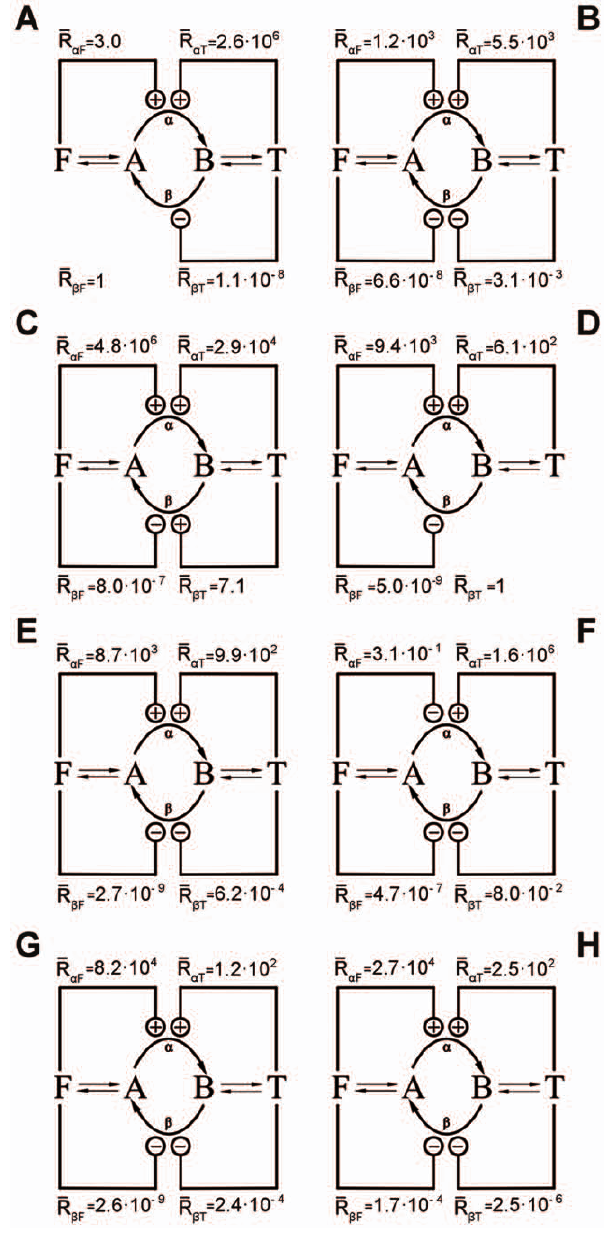
Figure 3. Regulation schemes obtained by the mono-objective methods for all the courses. Each diagram presents the values of R a , F , R a , T , R b , F , R b , T calculated with the resulting optimized parameters presented in Table